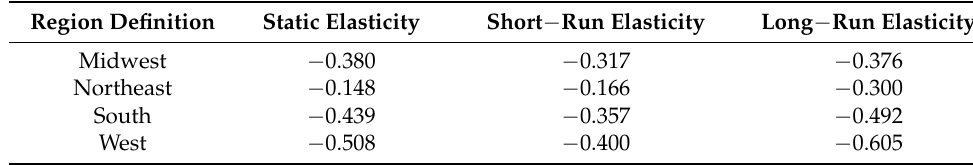
Table 8. Regional own-price elasticity